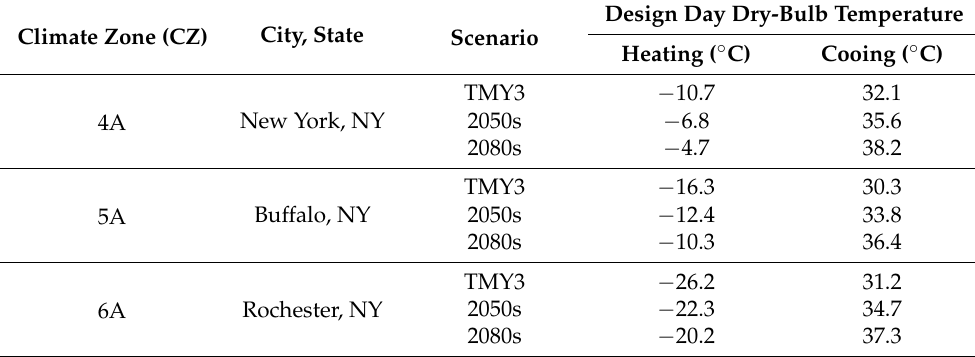
Table 7. Climate zones and its design-day weather